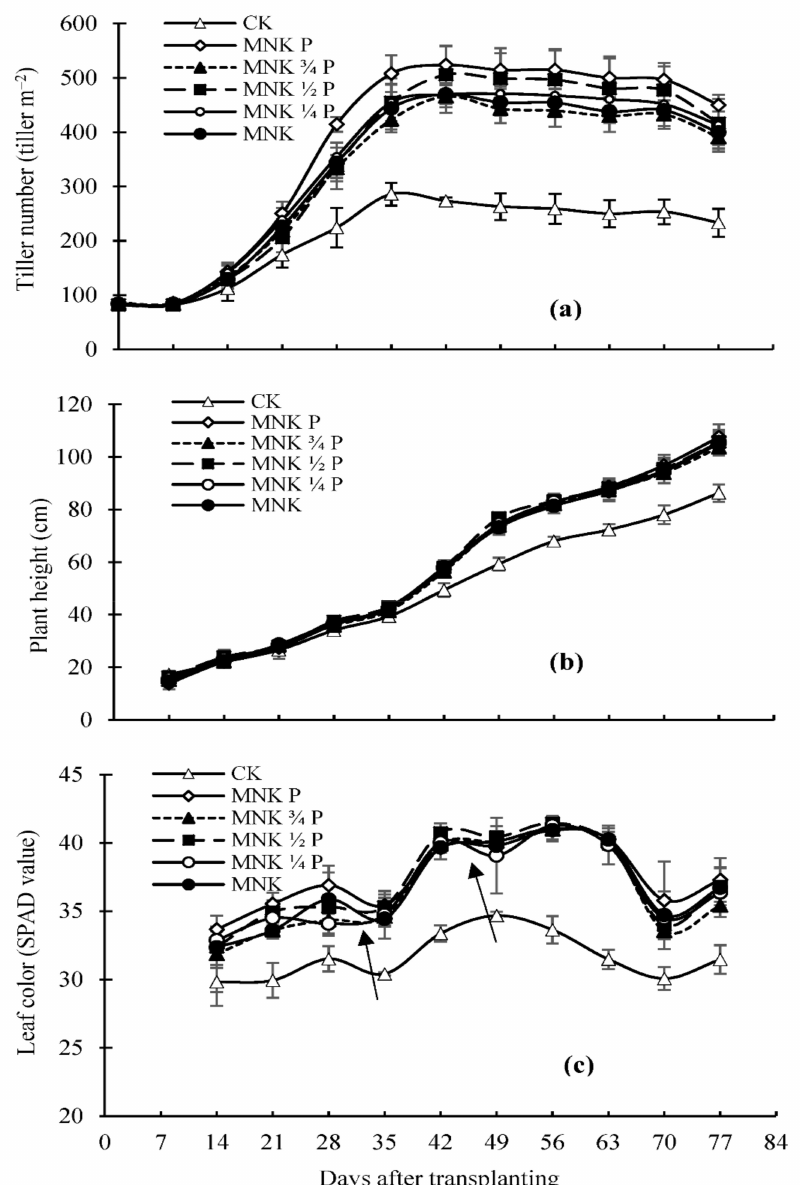
Figure 1. Changes in tiller numbers ( a ), plant heights ( b ), and leaf color in SPAD values ( c ) among treatments throughout the experiment. Bars indicate standard deviation ( n = 3). Arrows indicate the days of chemical N fertilizer